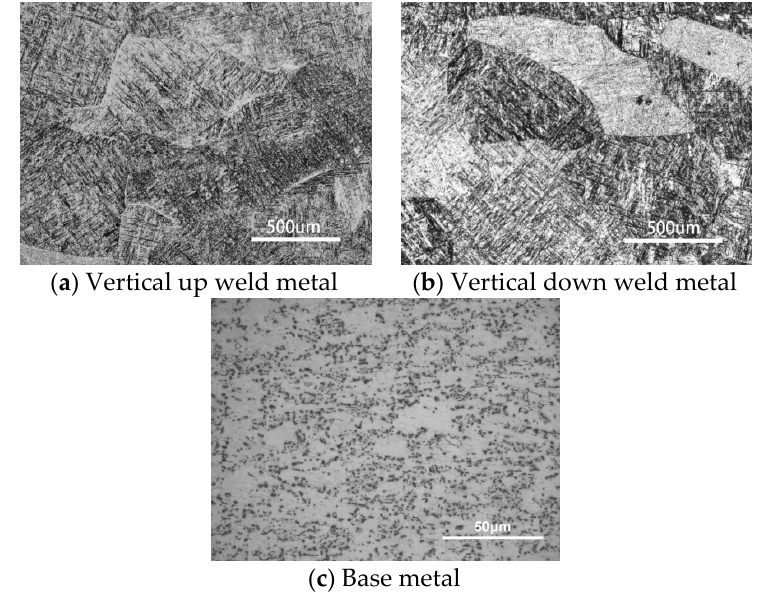
Figure 10. Microstructures of base metal and weld metals.